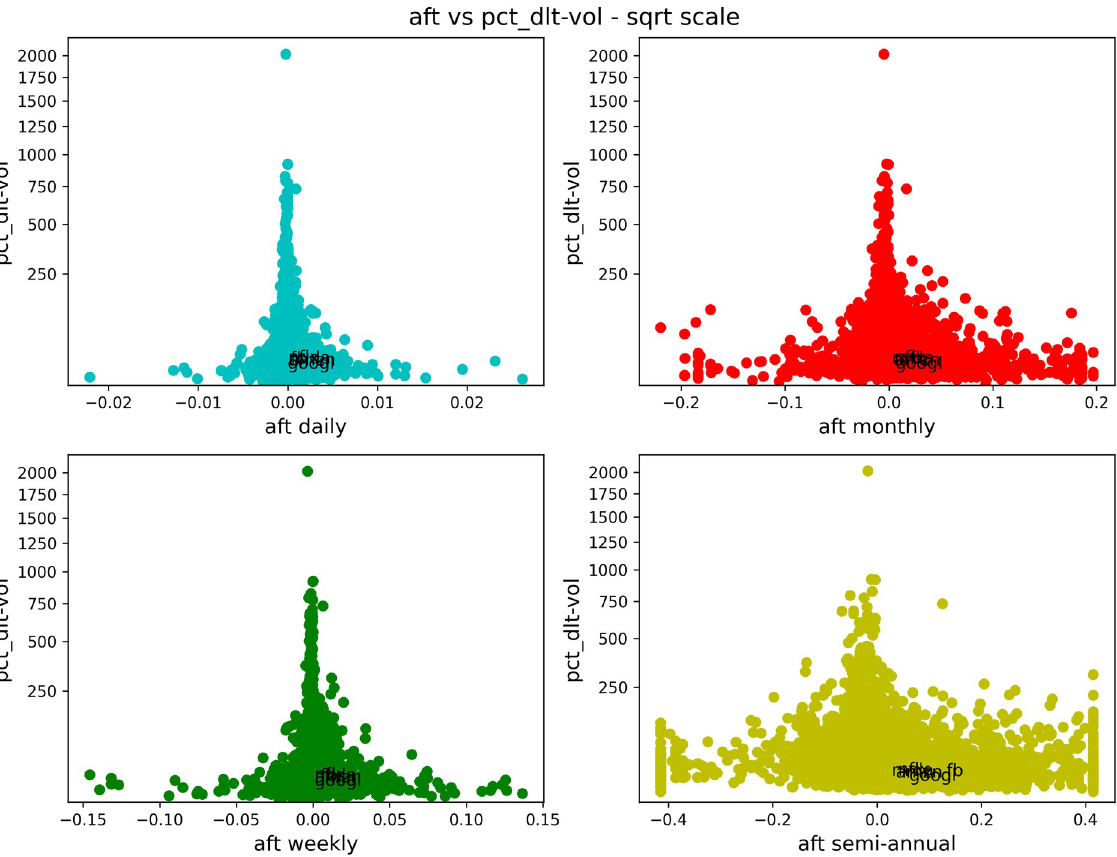
Fig 4. Comparison of antifragility values and pct_dlt-vol in stocks. Each subplot corresponds to a timescale (daily in cyan, weekly in green, monthly in red, semiannual in yellow). The plots compare the antifragility A measure (in the x -axis) to the pct_dlt-vol of each asset. We observe how higher values of the ‘good-performance’ measure concentrate in the robust axis A = 0